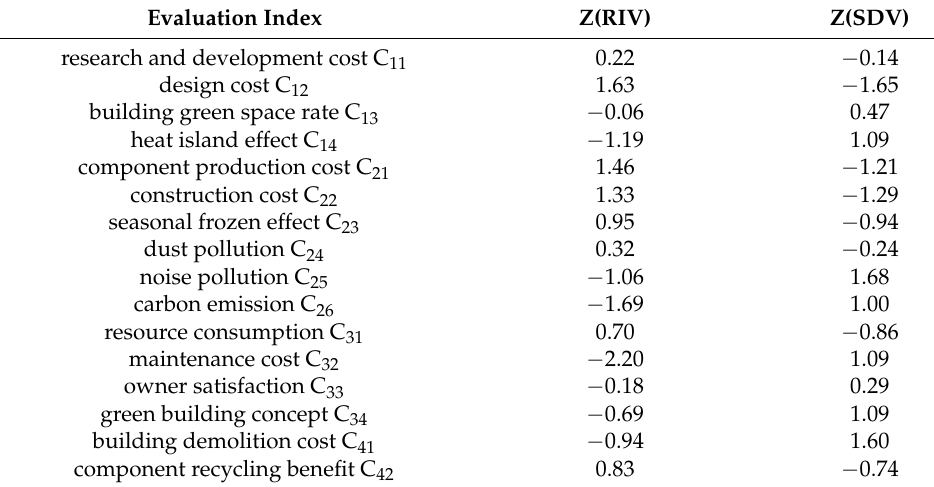
Table 2. Index cluster calculation results.